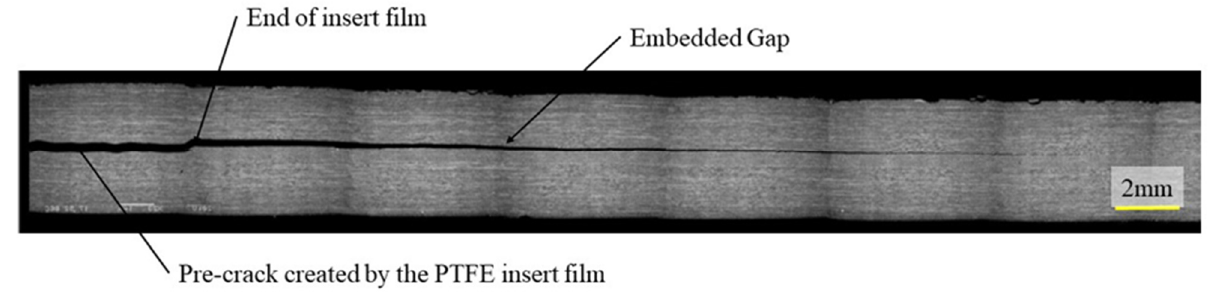
Figure 13. Example of a Mode II crack propagation path on a specimen with a 0.5 mm gap with caul plate.